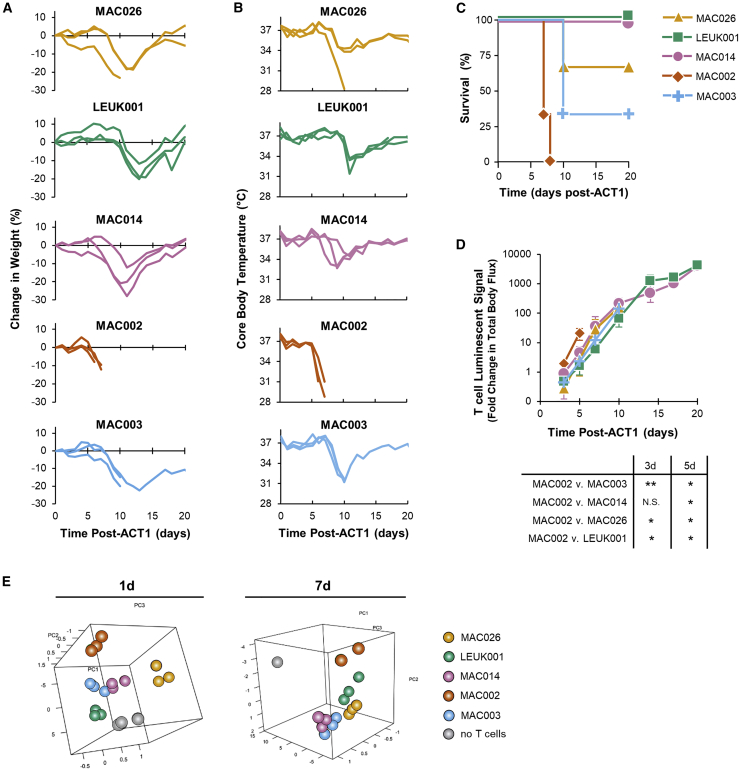
Donor-to-Donor Differences in CD4+ DARPin-28z-T Cell Toxicity Were Associated with Differences in Expansion and Cytokine ProductionPurified CD4+ DARPin-28z-CAR-T cells were generated from a panel of five different PBMC donors: MAC026 (gold/triangles), LEUK001 (teal/squares), MAC014 (pink/circles), MAC002 (orange/diamonds), and MAC003 (blue/crosses); cells were co-transduced with a firefly luciferase-expressing lentivirus. Tumor-bearing NRG mice were treated with 2.0 × 106 DARPin-28z-T cells. (A–C) Mice were followed for changes in weight (A), core body temperature (B) (each line shows data from one mouse; n = 3 per donor), and survival (C). (D) Bioluminescent imaging was used to follow T cell persistence and expansion; fold change in total body flux (p/s), relative to total body flux at 1 day post-ACT1, is presented. Per donor, data indicate average values ± SD; curves end, indicating when the first mouse in group succumbed to toxicity. Unless otherwise stated, differences between donors are not significant. (E) Mice were bled at 1 and 7 days post-ACT1. Serum levels for a 13-plex panel of human cytokines were determined by multiplex analysis. Log2-transformed fluorescence intensity values were analyzed via PCA. Each sphere indicates data from one mouse. Gray spheres indicate data from no T cell control mice (vehicle treatment only). The same dataset has been analyzed by hierarchical clustering in Figure S13 and for strength of correlation with toxicity in Figure S14.